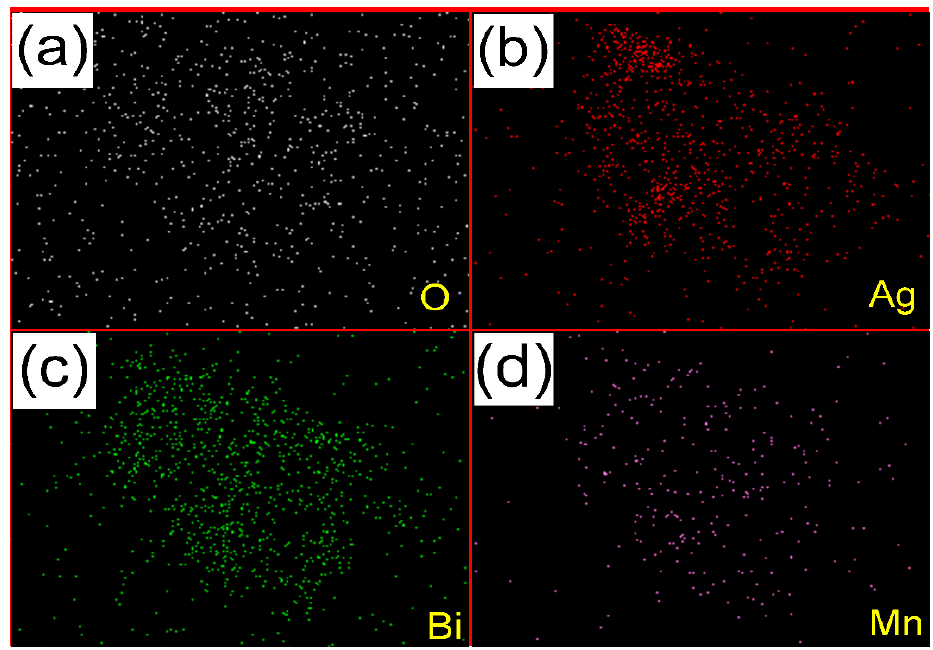
Figure 5. Elemental mapping images of Ag 4 Bi 2 O 5 with 60% Mn ( a ) O element, ( b ) Ag element, ( c ) Bi element, ( d ) Mn element.